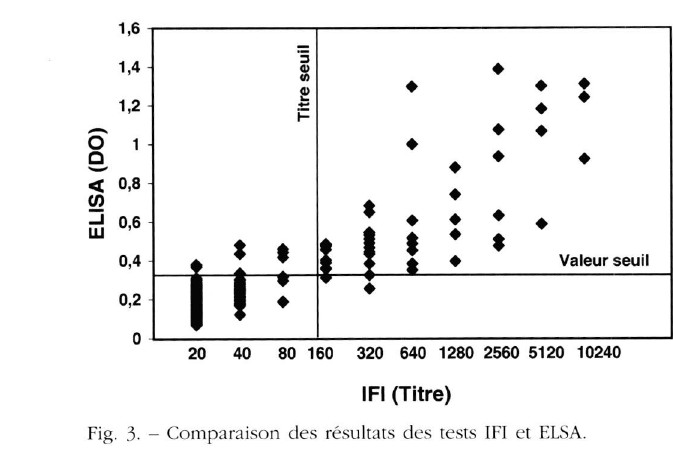
de la maladie à partir de l'âge de quatre ans. En effet, ne dépassant pas 11,1 % chez les chiens âgés de moins de deux ans, la prévalence atteint 28,6 % chez ceux âgés de quatre ans et